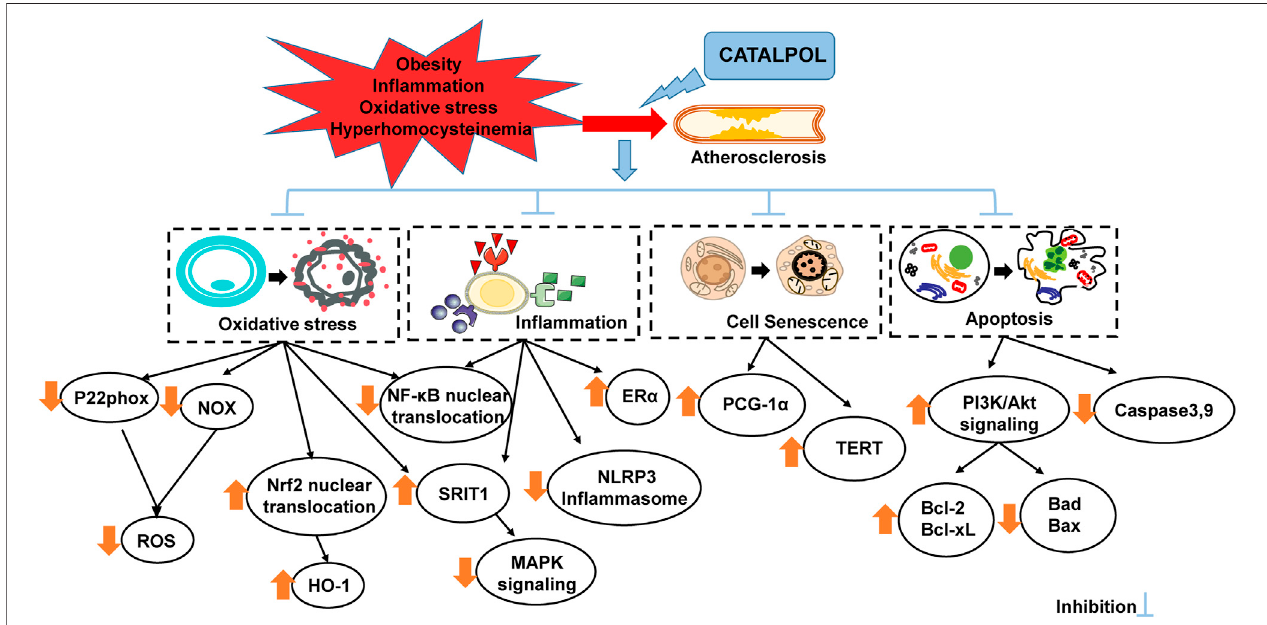
FIGURE 2 | The detailed mechanism of catalpol ’ s protective effect on